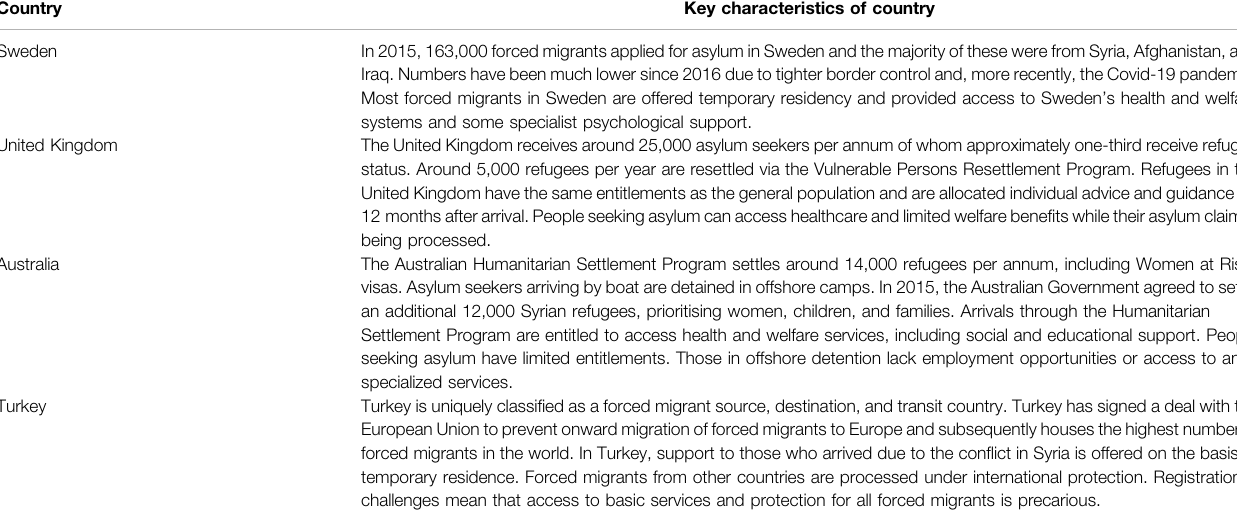
TABLE 1 | Characteristics of the comparison countries. Country Key characteristics of